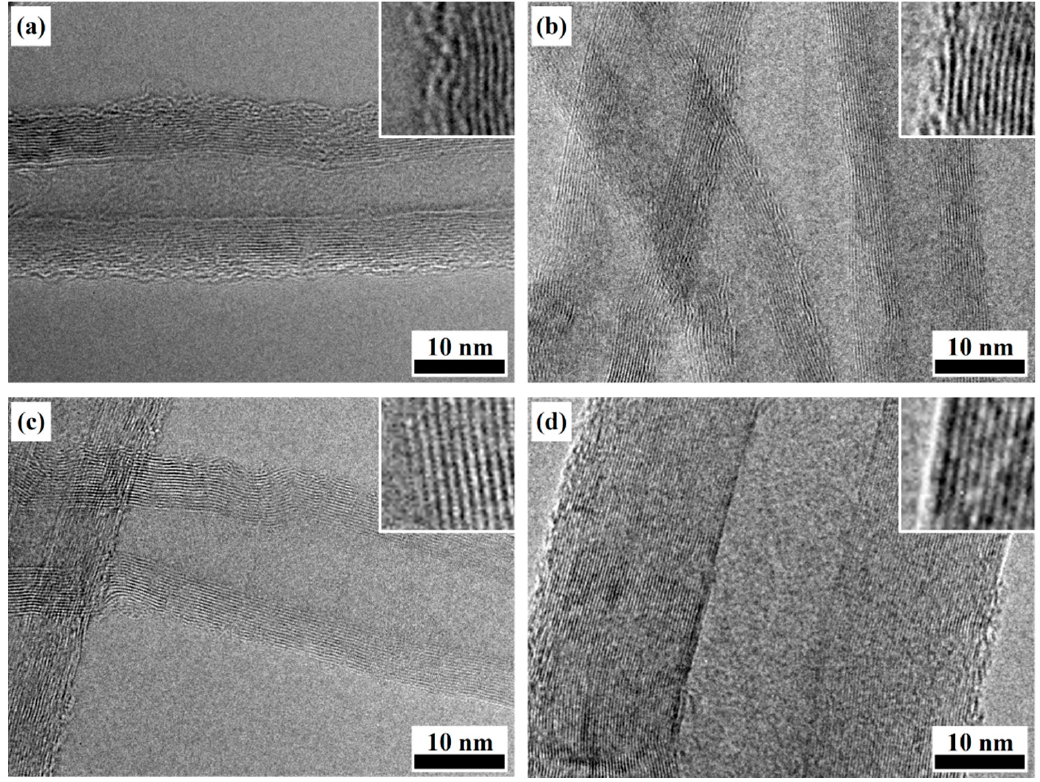
Figure 6. High resolution of TEM images of MWCNT using catalysts reduced at ( a ) 600, ( b ) 700, ( c ) 800, and ( d ) 900 °C, respectively.